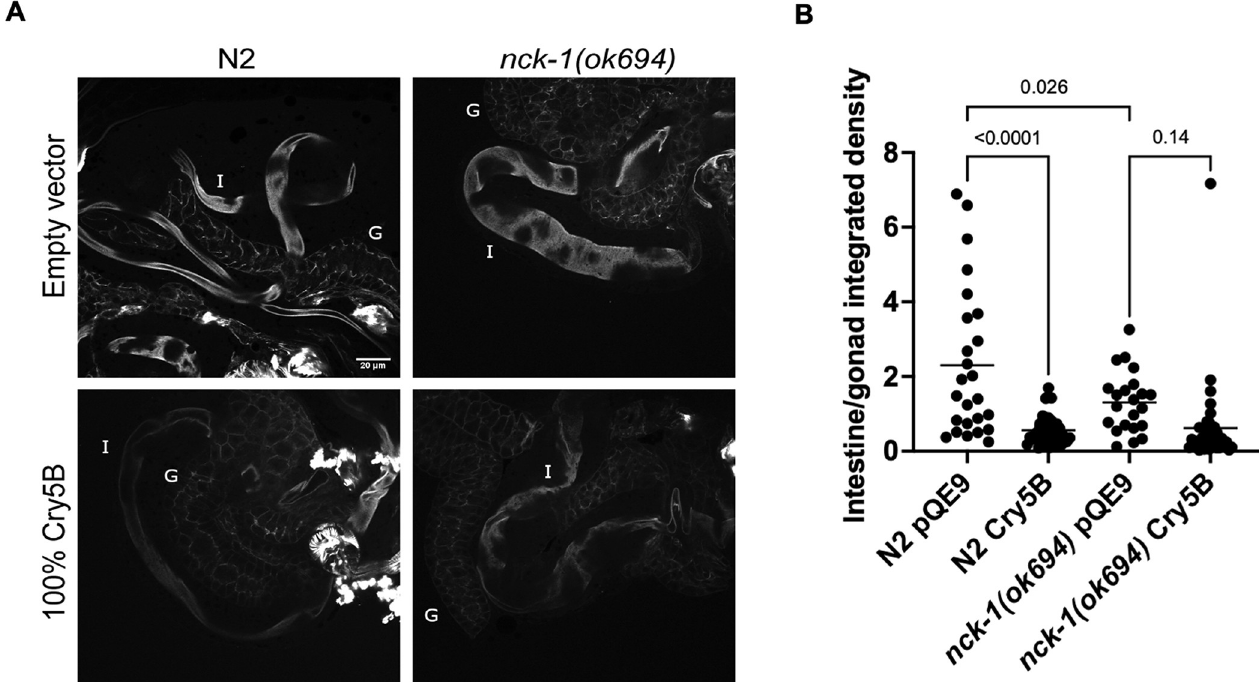
Fig 8. Cry5B exposure causes a reduction in intestinal F-actin levels. (A) Wild-type N2 or nck-1(ok694) C . elegans L4 animals were fed E . coli -expressed Cry5B or empty vector for 2 hours, permeabilized, and then their internal organs were fixed and stained with FITC-phalloidin. The honeycombed staining is the gonad (labeled G in the upper panels) and the smoother staining is the intestine (I). (B) The integrated density from images (mean pixel intensity x area) of the intestine divided by that of the gonad following the two-hour toxin incubation was graphed. Each dot represents one worm. The data come from three experiments (n = 10 animals per condition and per genotype per trial), and the bars show the mean. Statistical analyses are as described in the